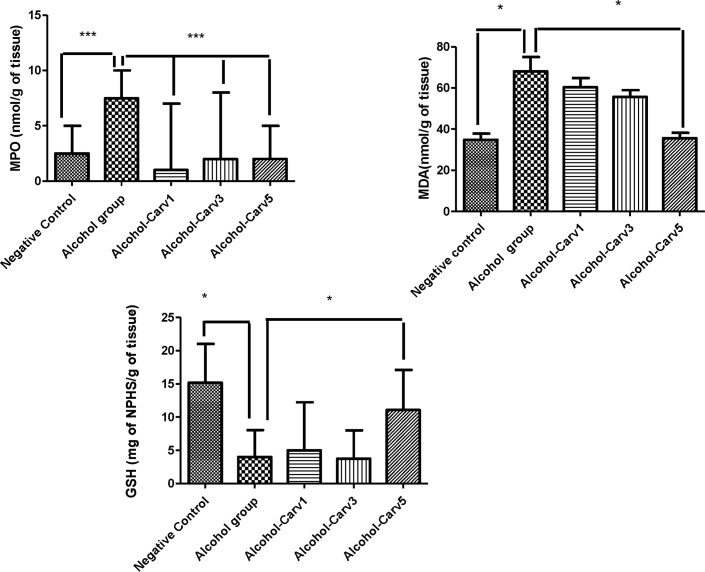
CARV modulates MPO activity, MDA activity, and GSH levels in the livers of rats with alcohol-induced liver injury.Experiments were conducted in duplicate. *p < 0.05; ***p < 0.001.